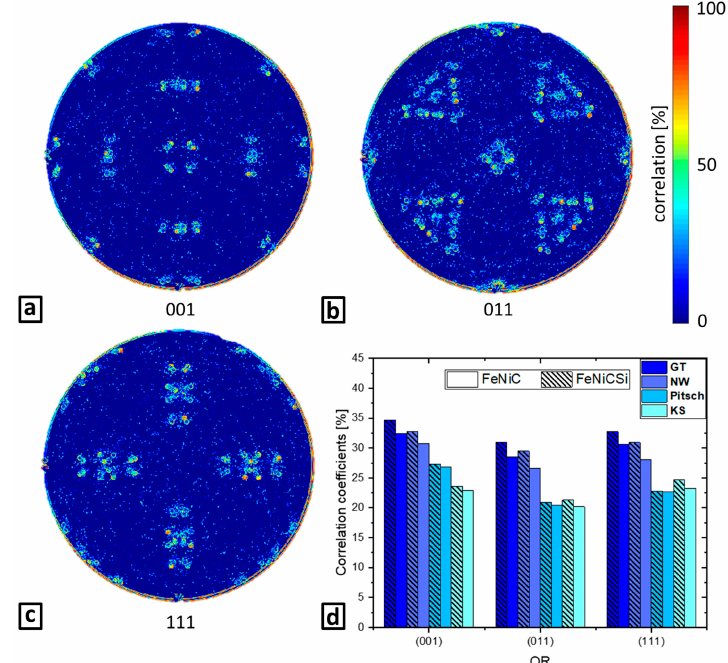
Figure 8. Subtraction of simulated (here GT) from experimental ( a ) (001) ( b ) (011) and ( c ) (111) pole figures for FeNiCSi; ( d ) Correlation coefficients of FeNiC and FeNiCSi, respectively, with the simu- lated pole figures to enable quantitative analysis. simulated pole figures to enable quantitative